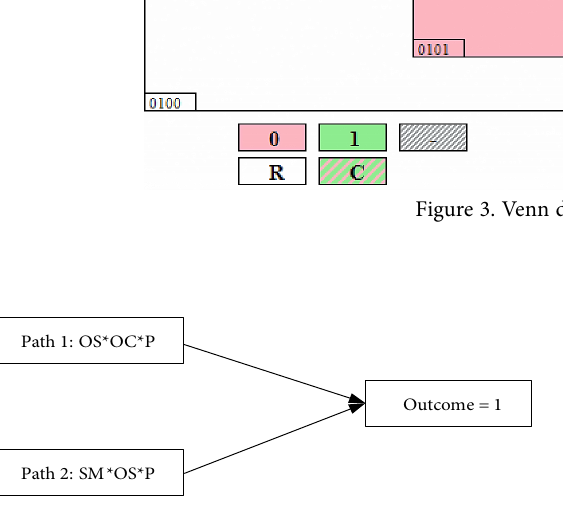
Figure 4. Conditional combination path